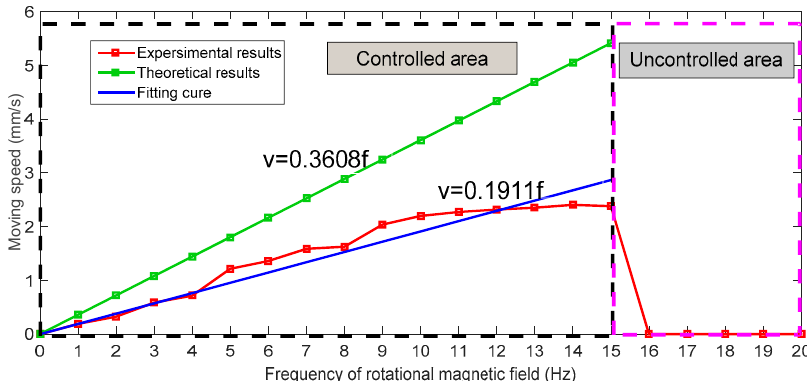
Figure 14. Relationship between the magnetic changing frequency and moving speed.